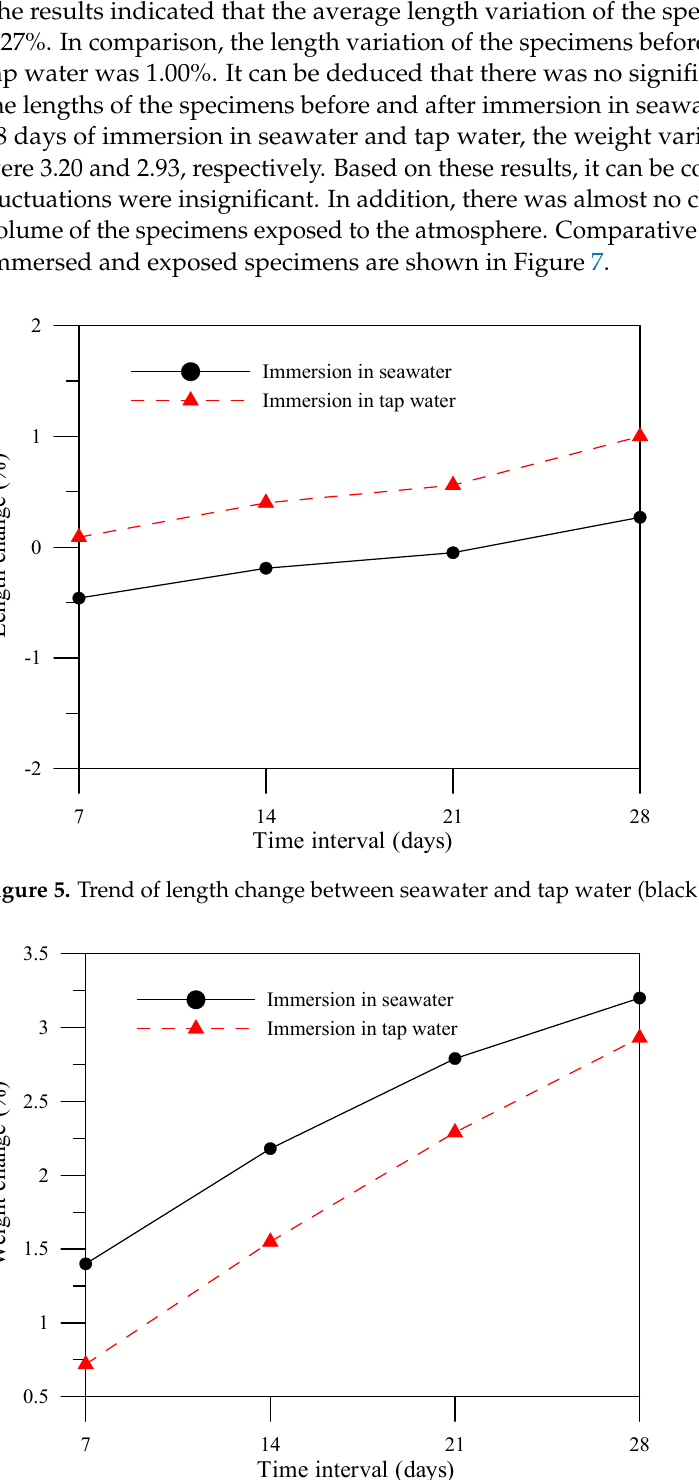
Figure 4. Length change curves.